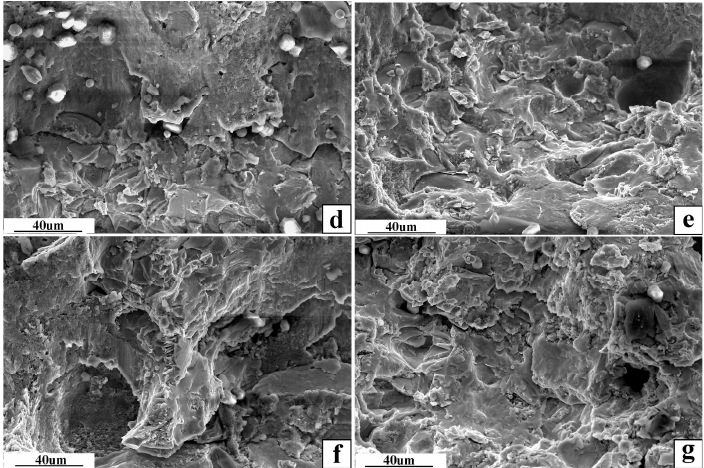
Figure 14. SEM image of the selected area in Figure 13. ( d – g ) in Figure 14 are partially enlarged views of the same red-framed marked area in the upper left corner of Figure 13.